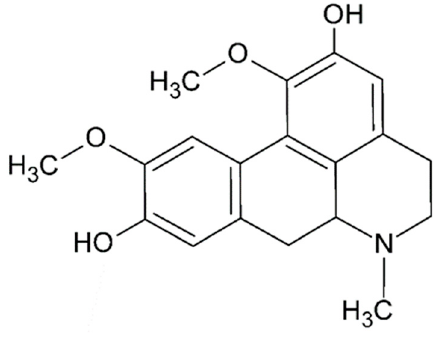
Figure 2. Molecular structure of boldine.